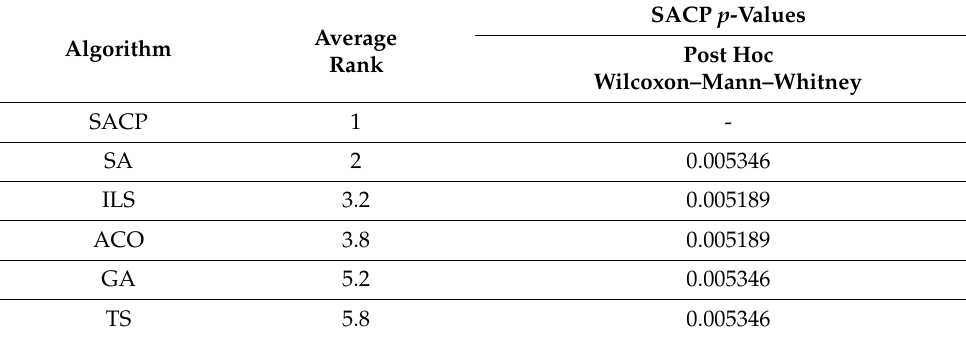
Table 6. Post hoc test and average ranking for multiple p -values comparisons between SACP vs. other algorithms taking only data from small